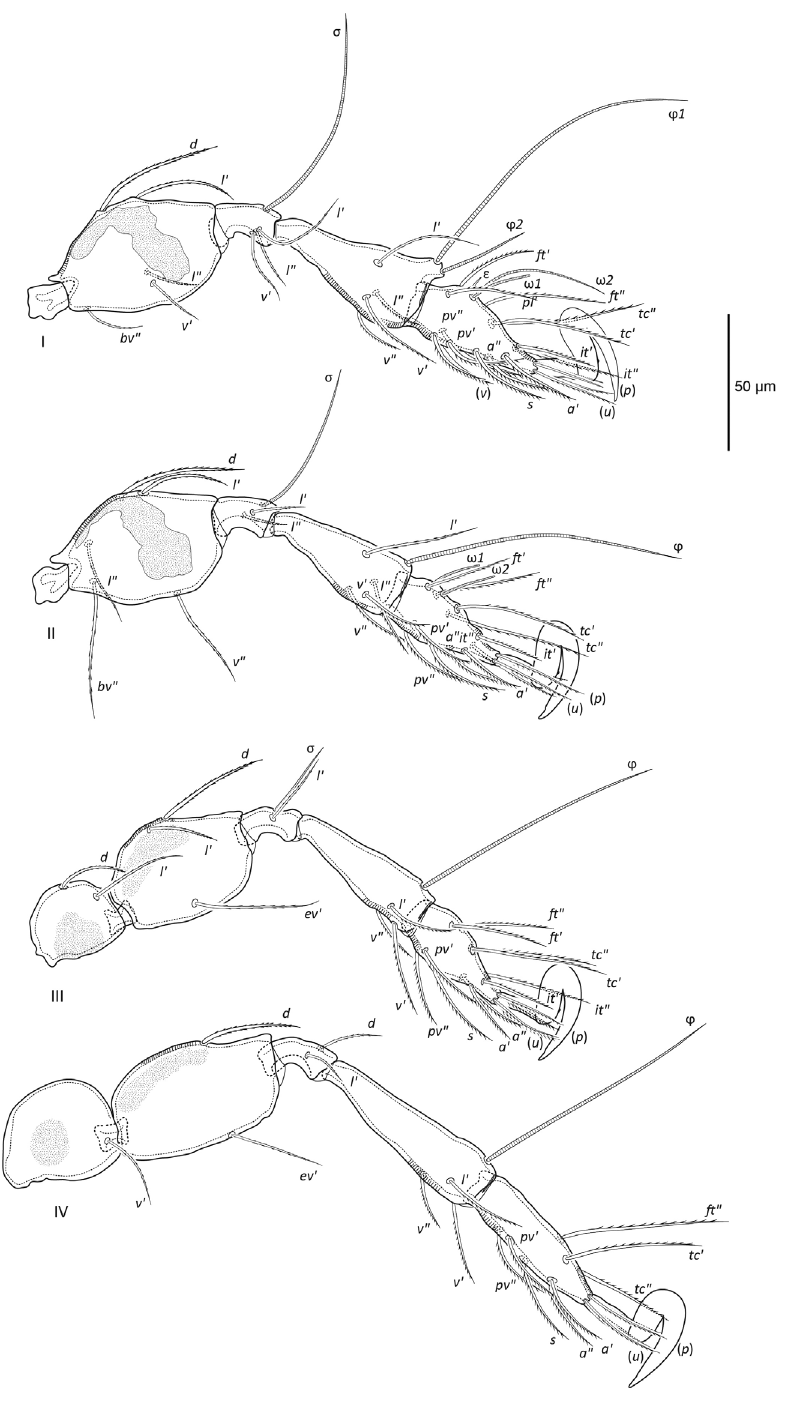
Figure 6. Female Paraleius leahae sp. n. legs; legs I, II paraxial view, legs III, IV antiaxial